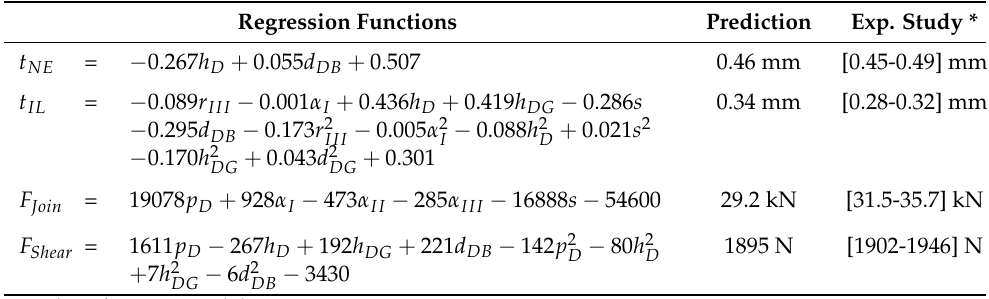
Table 4. Overview of the regression functions and their performances compared to experimental